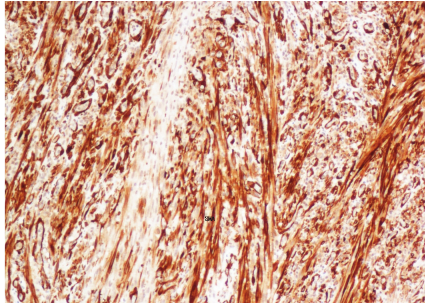
Figure 5: Positive staining for SMA in the sarcomatous component.